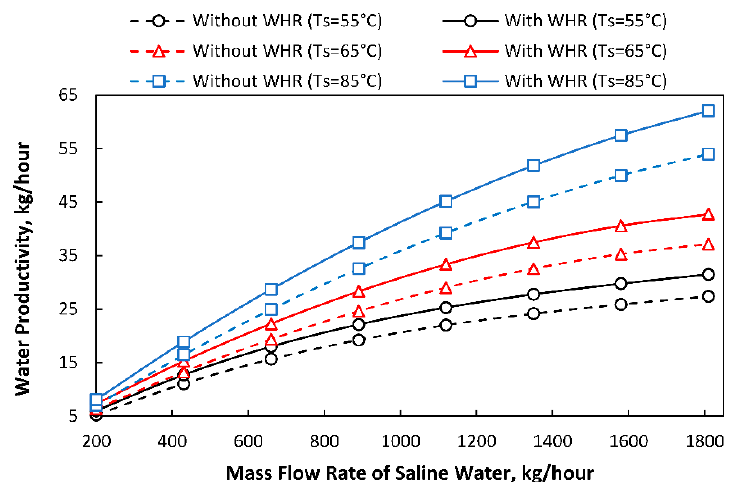
Figure 8. Effect of MFR of saline water on water production with and without waste heat recovery.